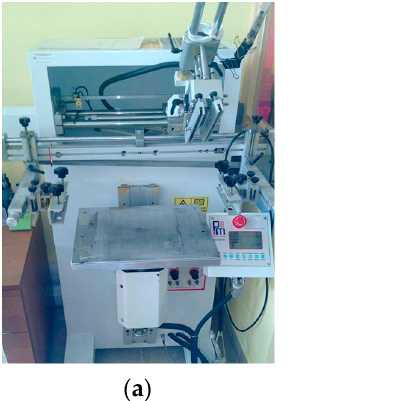
Figure 1. ( a ) The MS-300 machine used in the screen-printing method, ( b ) “Tajima” embroidery machine, model: “TMEX-C1201”.